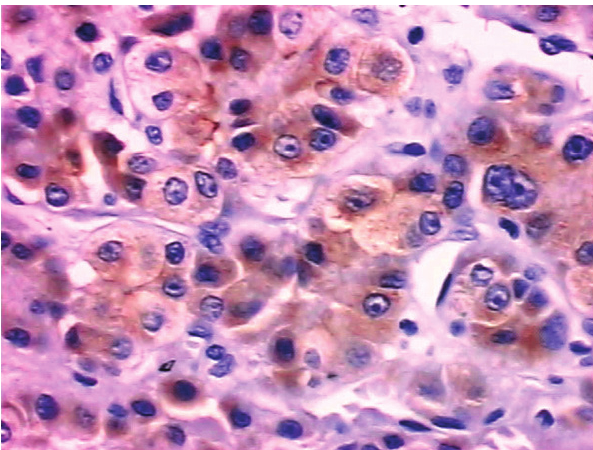
Figure 2, Panel B. Immunohistochemistry shows positive staining of the tumor cells with a low-molecular-weight cytokeratin, CAM 5.2 (magnification, 400x).